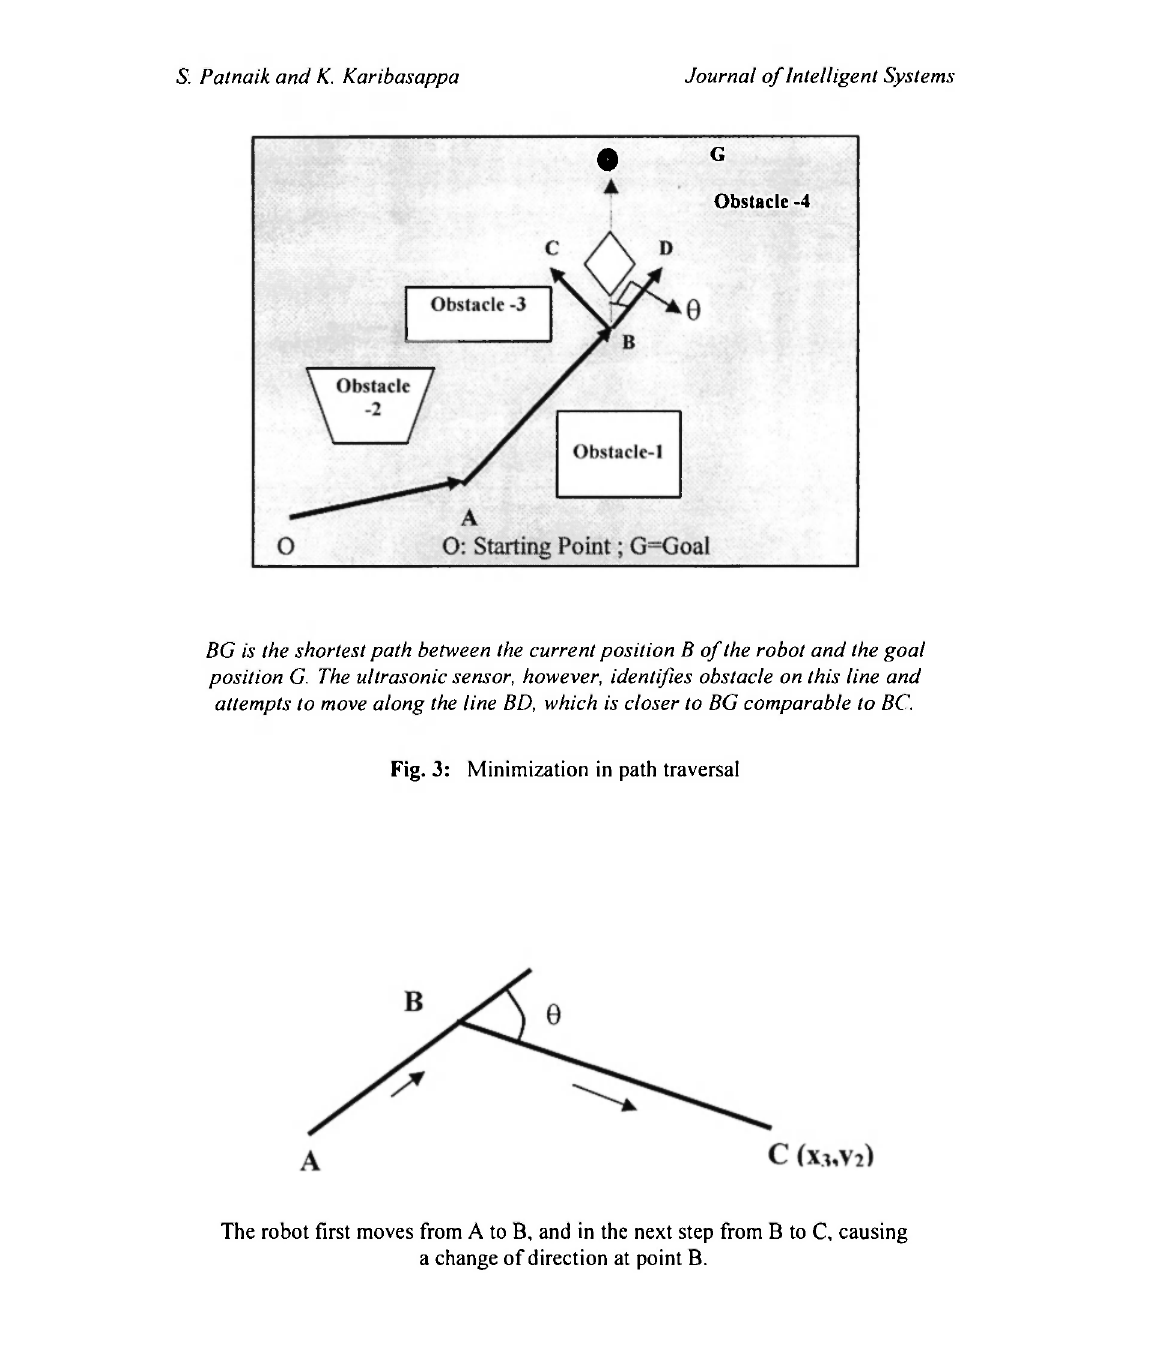
Fig. 4: The change of movement direction by the